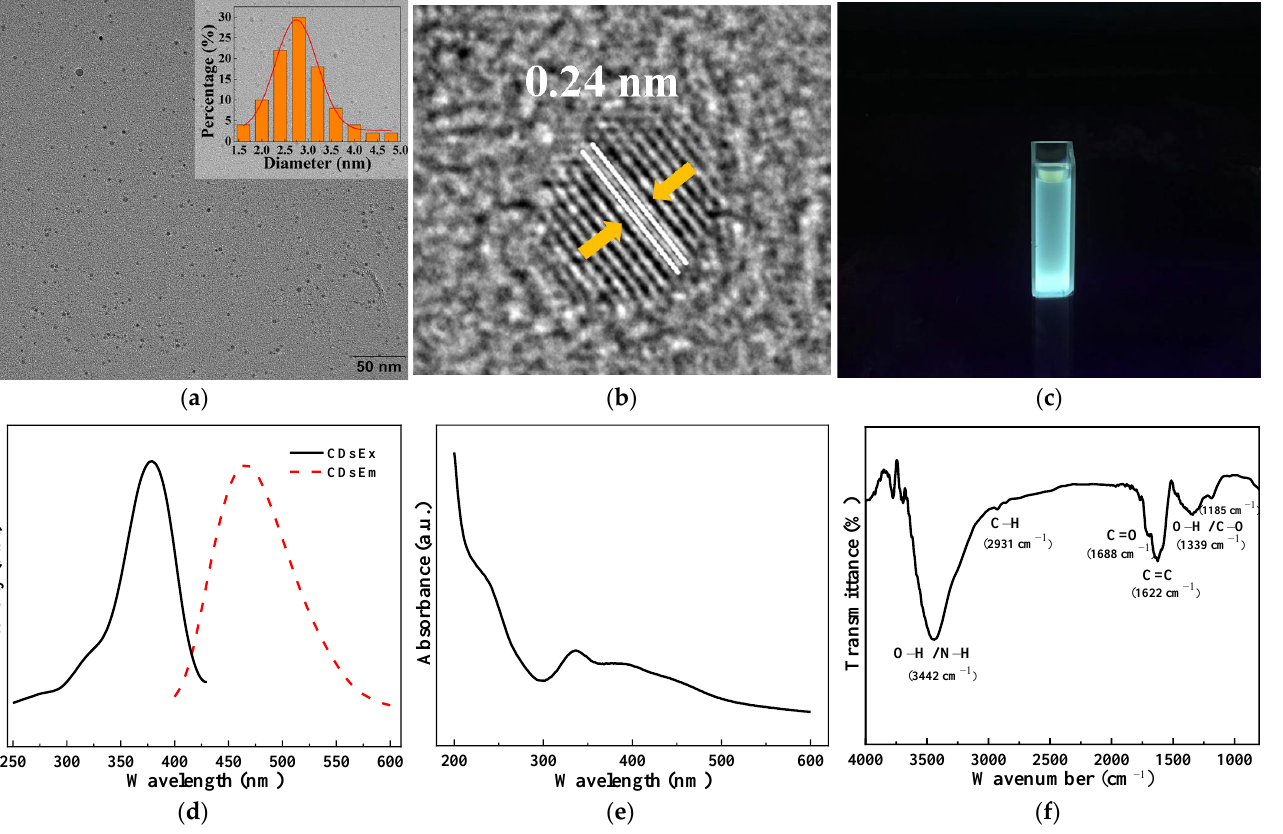
Figure 1. Characteristics of CDs. ( a ) TEM image of CDs (inset: particle size distribution); ( b ) HRTEM image of CDs; ( c ) photo of CD powder aqueous solution under 365 nm UV radiation; ( d ) PL spectra of CDs; ( e ) UV‒vis spectra of CDs; ( f ) FT-IR spectra of CDs.